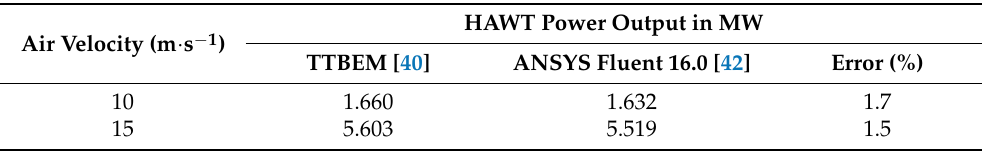
Table 2. Power output of a three-bladed HAWT with blades constructed by NREL S809 airfoil in airflow, calculated by TTBEM application [40] and ANSYS Fluent 16.0 [42].